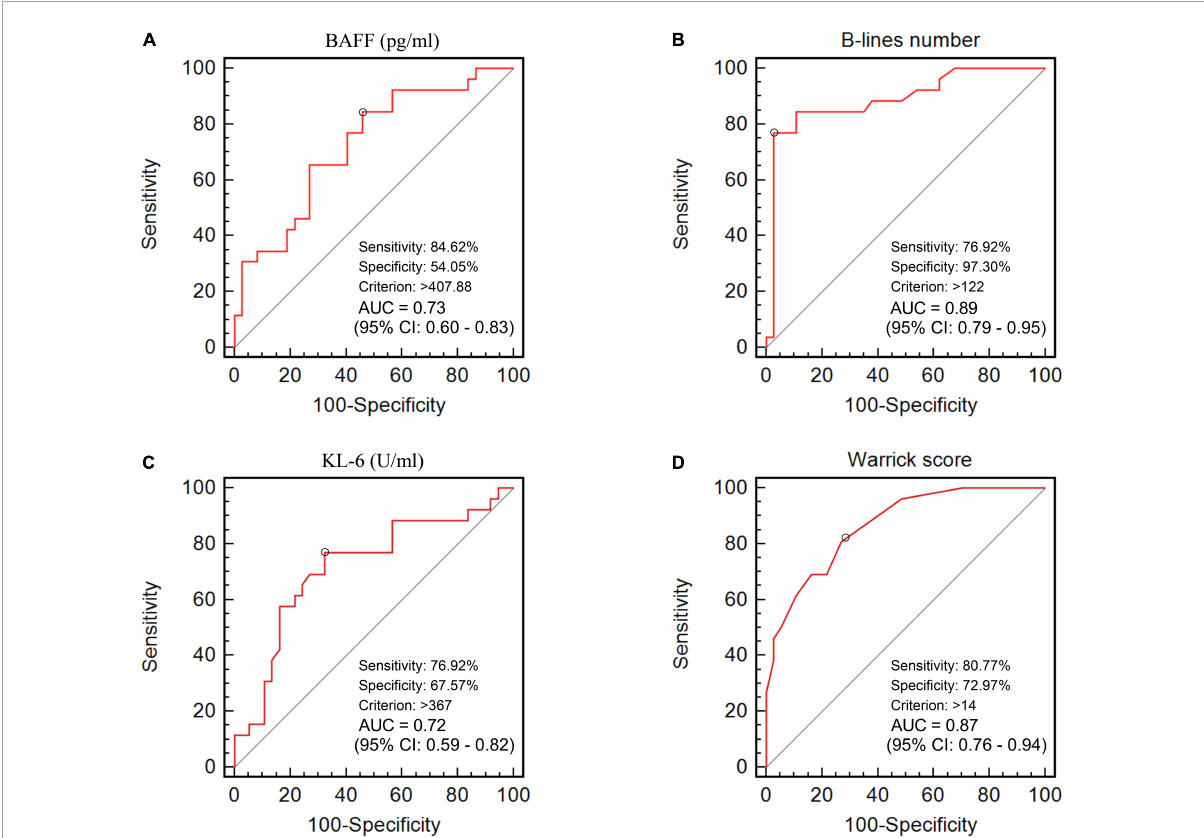
FIGURE3 The area under the receiver operating characteristic curves of (A) BAFF level (pg/ml), (B) B-lines number, (C) KL-6 level (U/ml), and (D) HRCT Warrick score for the discrimination between F-ILD and NF-ILD.